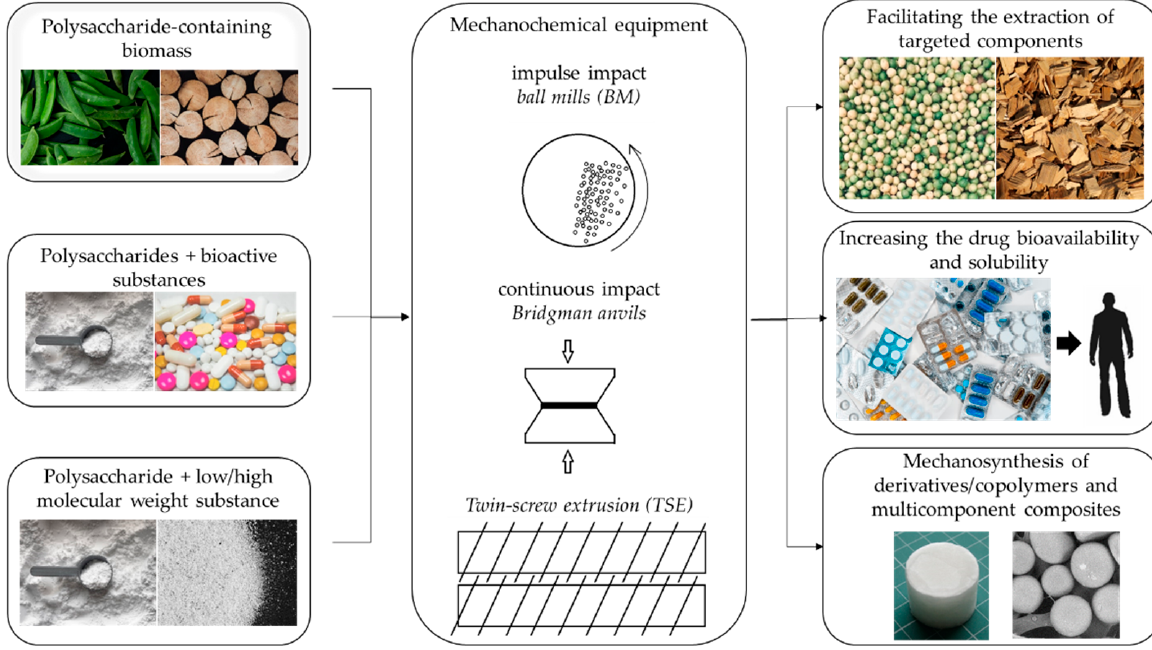
Figure 2. The main trends of mechanochemical modification of polysaccharides.